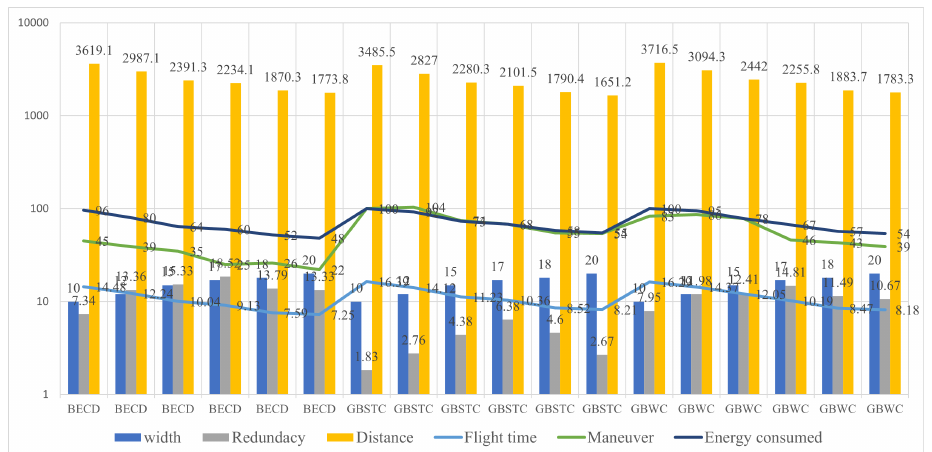
Figure 13. Performance metrics of 3DR Iris UAV on Unioeste PV plants (Experiment 4).